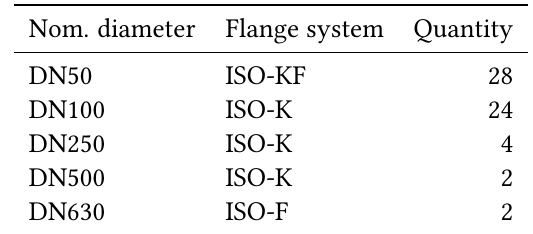
Table 1: Available flange